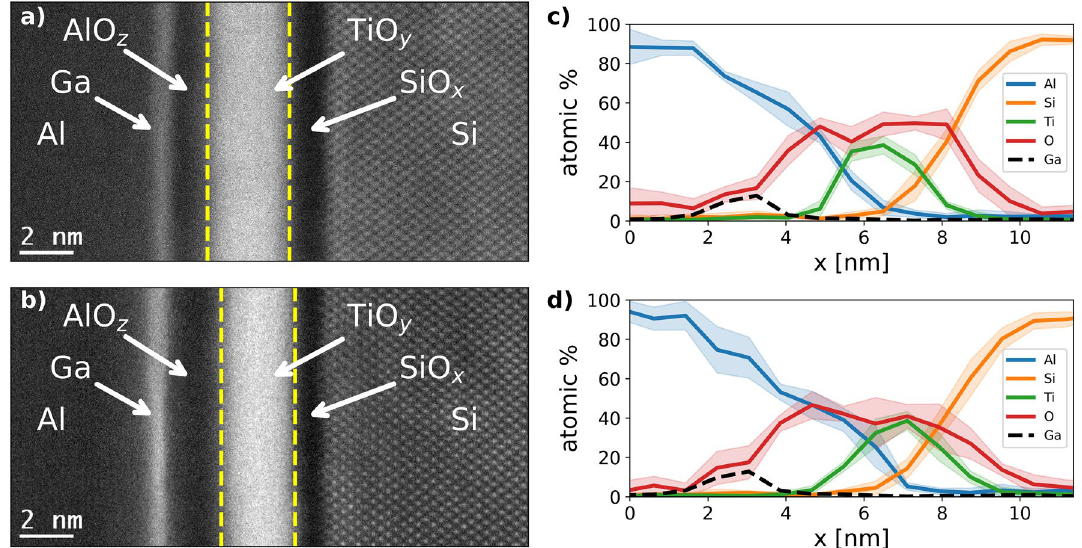
Figure 2. Rear contact layers and composition. ( a,b ) Show HAADF images of the as-depositedand the annealed solar cell rear contacts. The different layers of the contact stack are labeled, yellow dashed lines are added to illustrate the extend of the TiO y . ( c,d ) Depict the average of four EDX line scans over the contacts for as-deposited ( c ) and annealed ( d ) solar cells. The main constituents are depicted as solid lines, while Ga contamination is represented by a black, dashed line. The shaded areas represent plus-minus twice the standard deviation of the